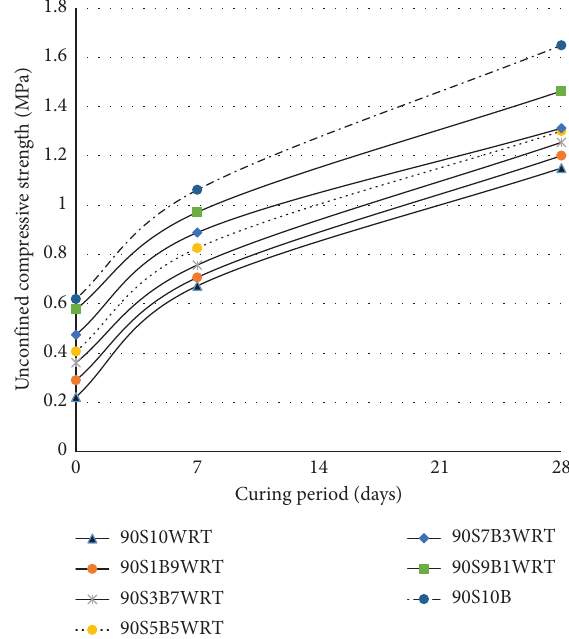
Figure 4: Unconfned compressive strength versus curing